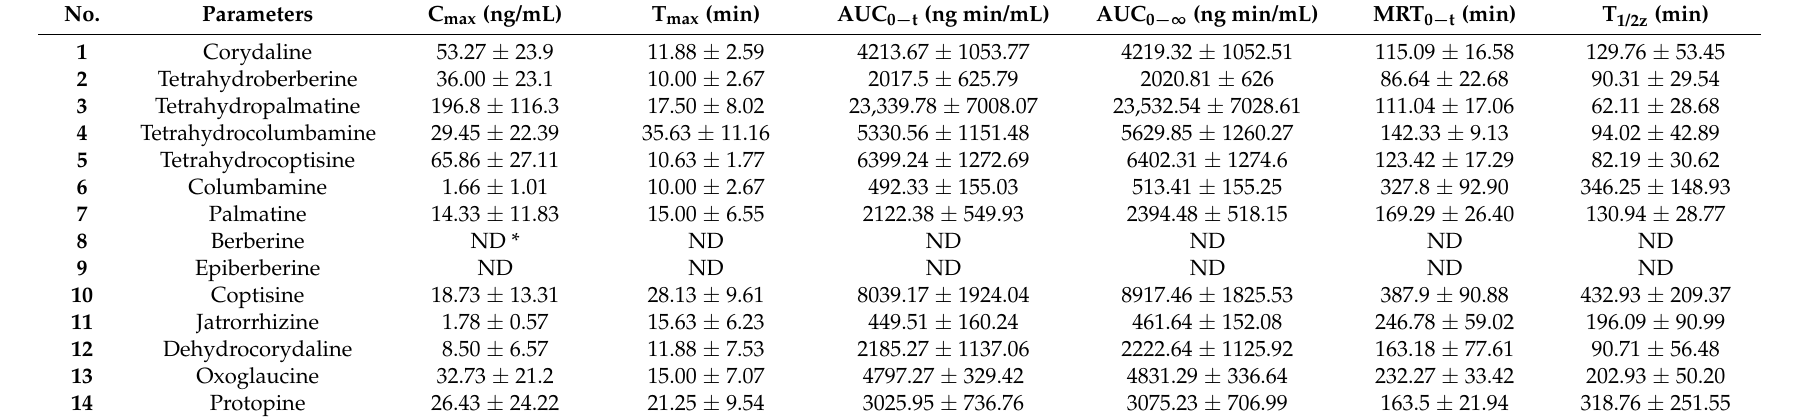
Table 7. Pharmacokinetic parameters of the fourteen alkaloids in male ICR mice after oral administration of Corydalis yanhusuo extract. ( n = 8, mean ±